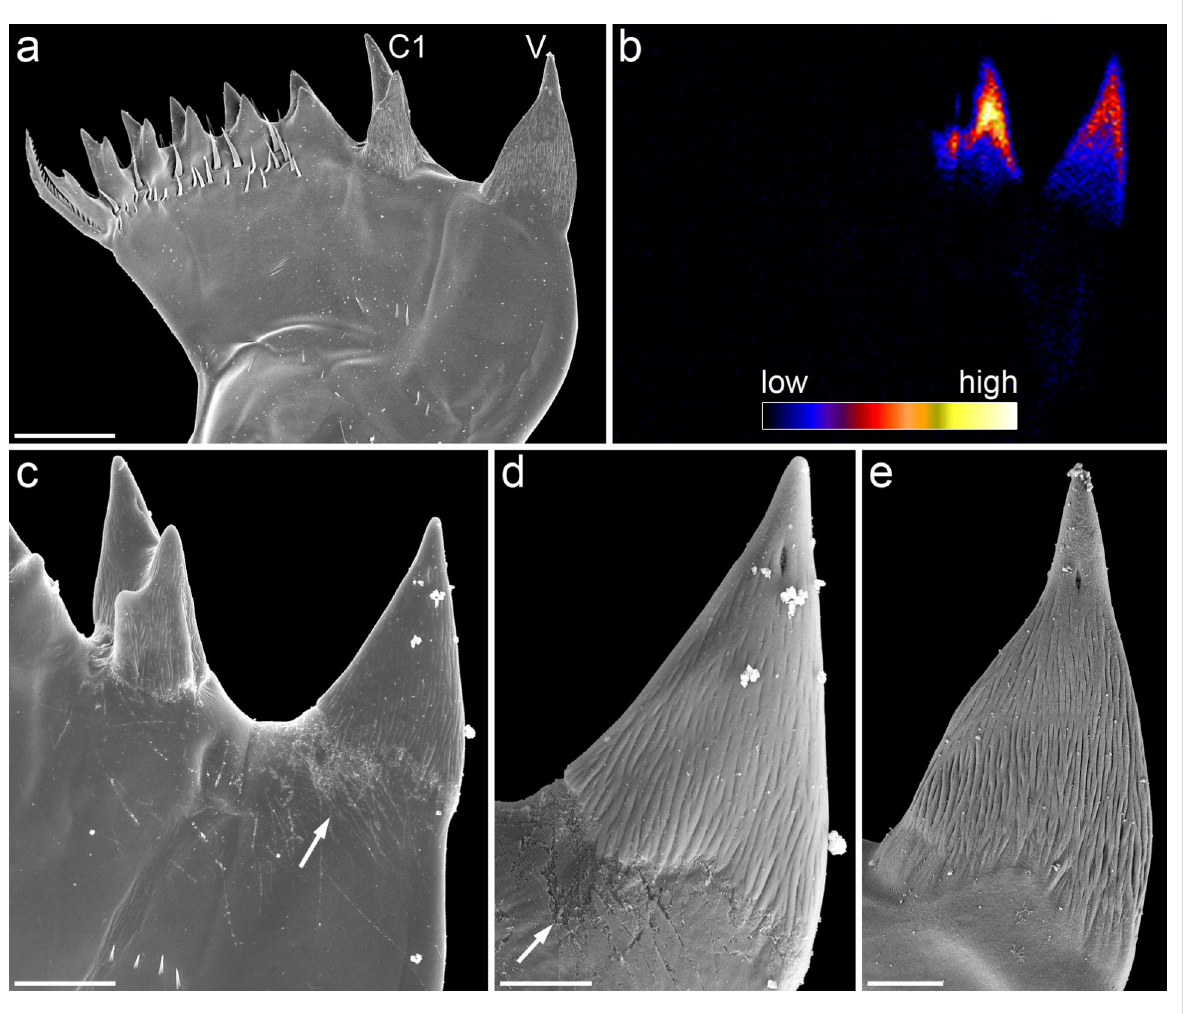
Figure 3: Mandibular gnathobases of female Centropages hamatus . (a, c–e) Scanning electron micrographs (all cranial view). (a) Overview of the distal part of a gnathobase. (c) Overview of the ventral part of the distal gnathobase structures. (d) Detailed view of the ventral tooth shown in (c). (e) Detailed view of the ventral tooth shown in (a). (b) Micro-particle-induced X-ray emission (µ-PIXE) mapping showing the distribution and concen- tration of silicon in the distal part of a gnathobase. The orientation of the gnathobase is similar to that of the gnathobase shown in (a). The results of the elemental analysis indicate that the ventral tooth (V) and the first central tooth (C1) contain silica. The arrows indicate areas with a large number of scratches. Scale bars = 20 µm (a), 10 µm (c), 5 µm (d, e). Figure reproduced with permission from